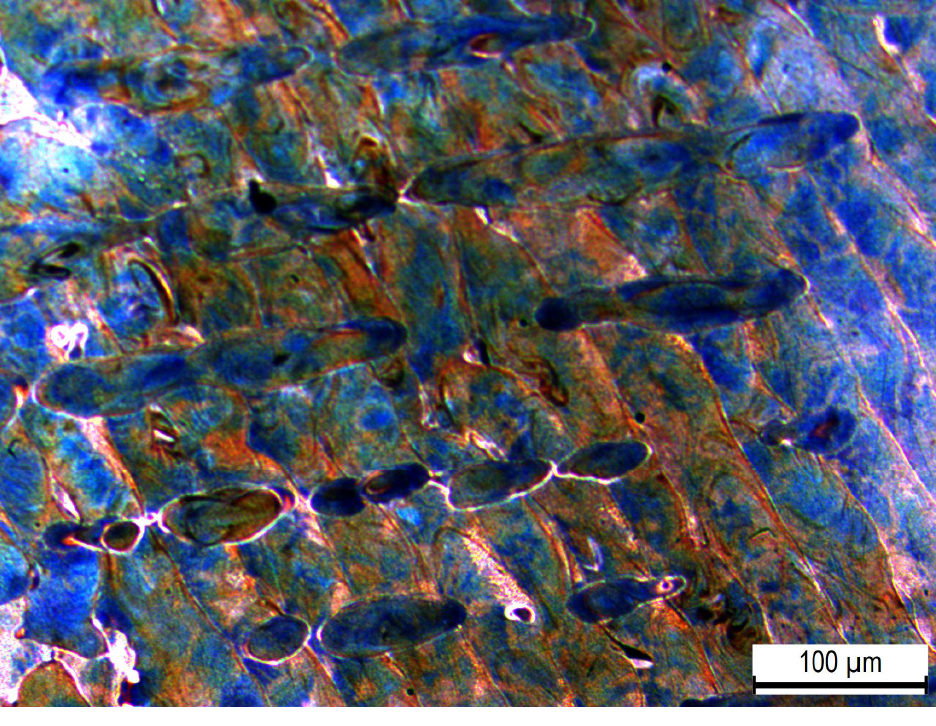
Figure 4. Austenitic microstructure of as-printed 316L SS.